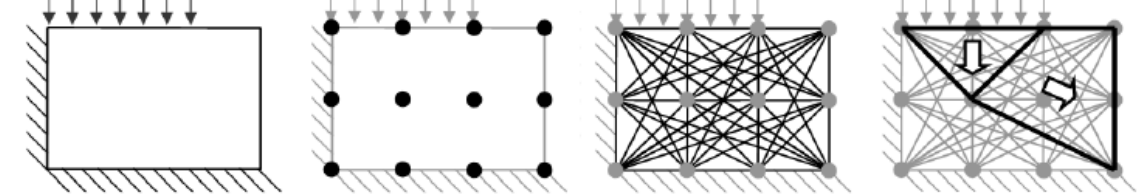
Figure 1. Stages in discontinuity layout optimization (DLO) procedure.